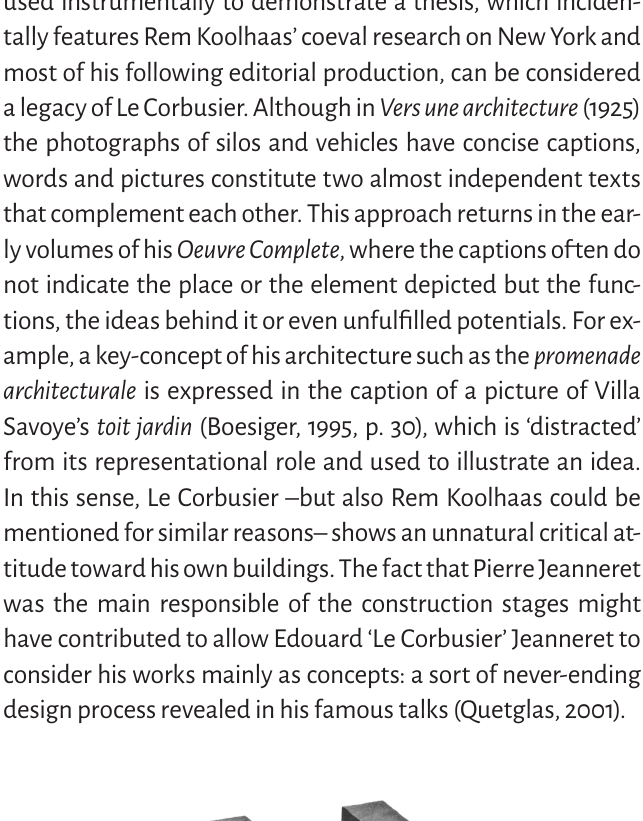
Fig. 10 Herman Hertzberger, Repeated Living Cells, Maquette with matchboxes , 1959 (Hertzberger, 1959, p.